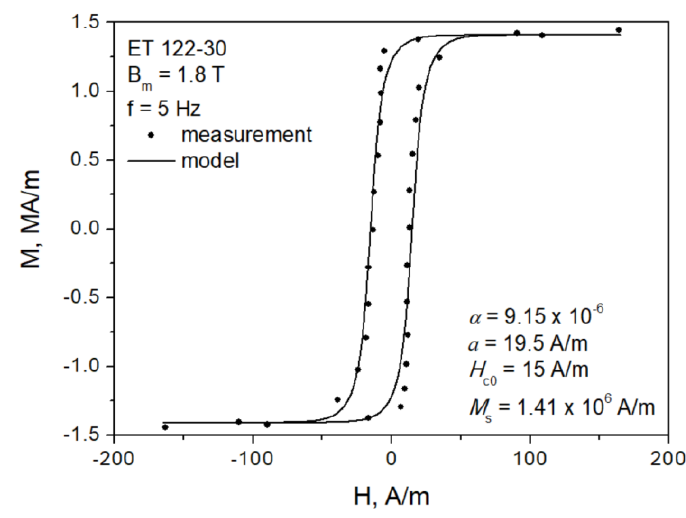
Figure 8. The measured and the modeled major loop for the considered grade.